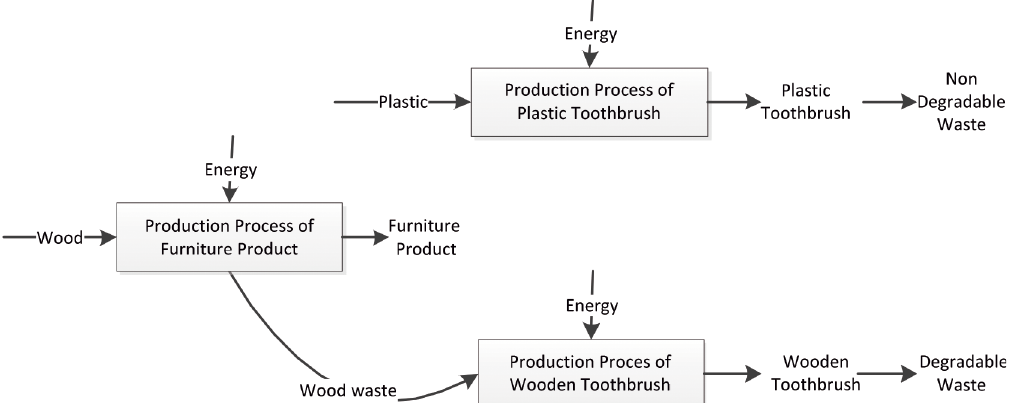
Figure 5. Evaluation boundary